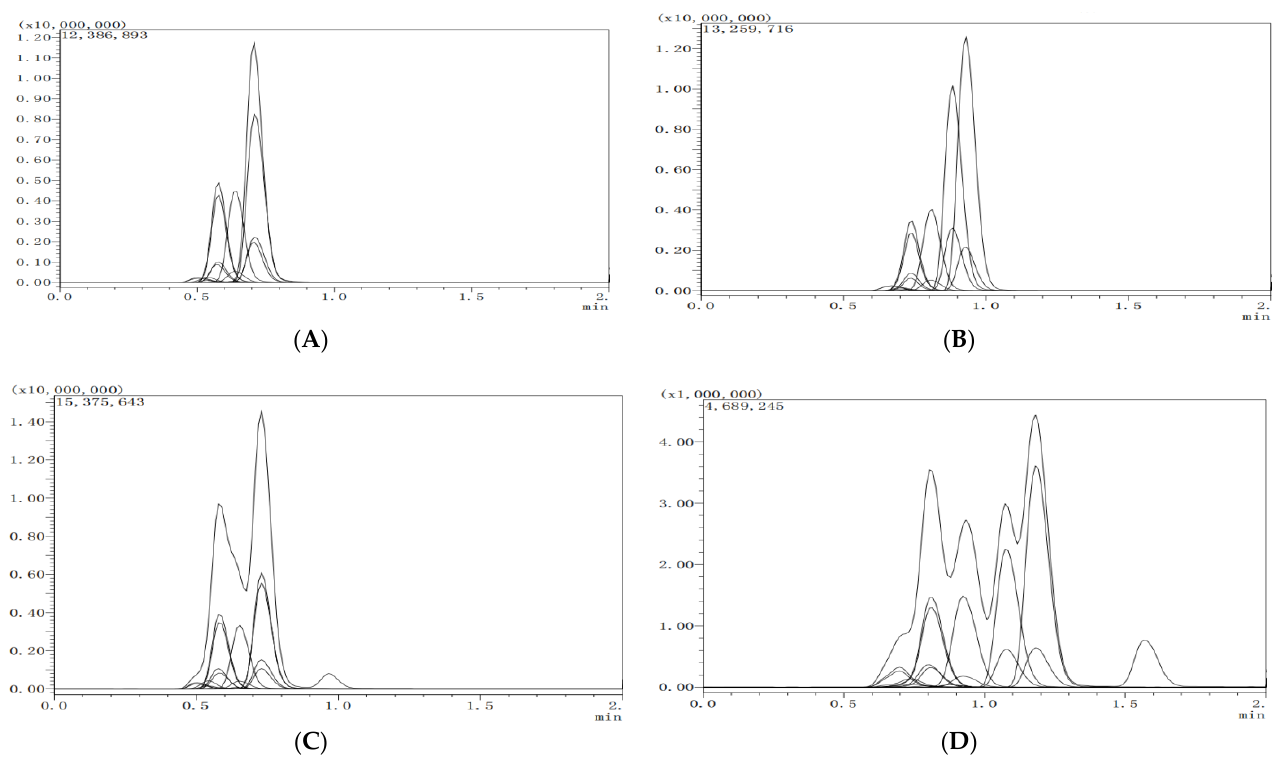
Figure 2. The chromatogram of eight targeted compounds separated by the different mobile phase components (lateral axis is time, and longitudinal axis is response intensity). ( A ) Methanol-water containing 0.1% formic acid; ( B ) acetonitrile-water containing 0.1% formic acid; ( C ) methanol-water; ( D ) acetonitrile-water.